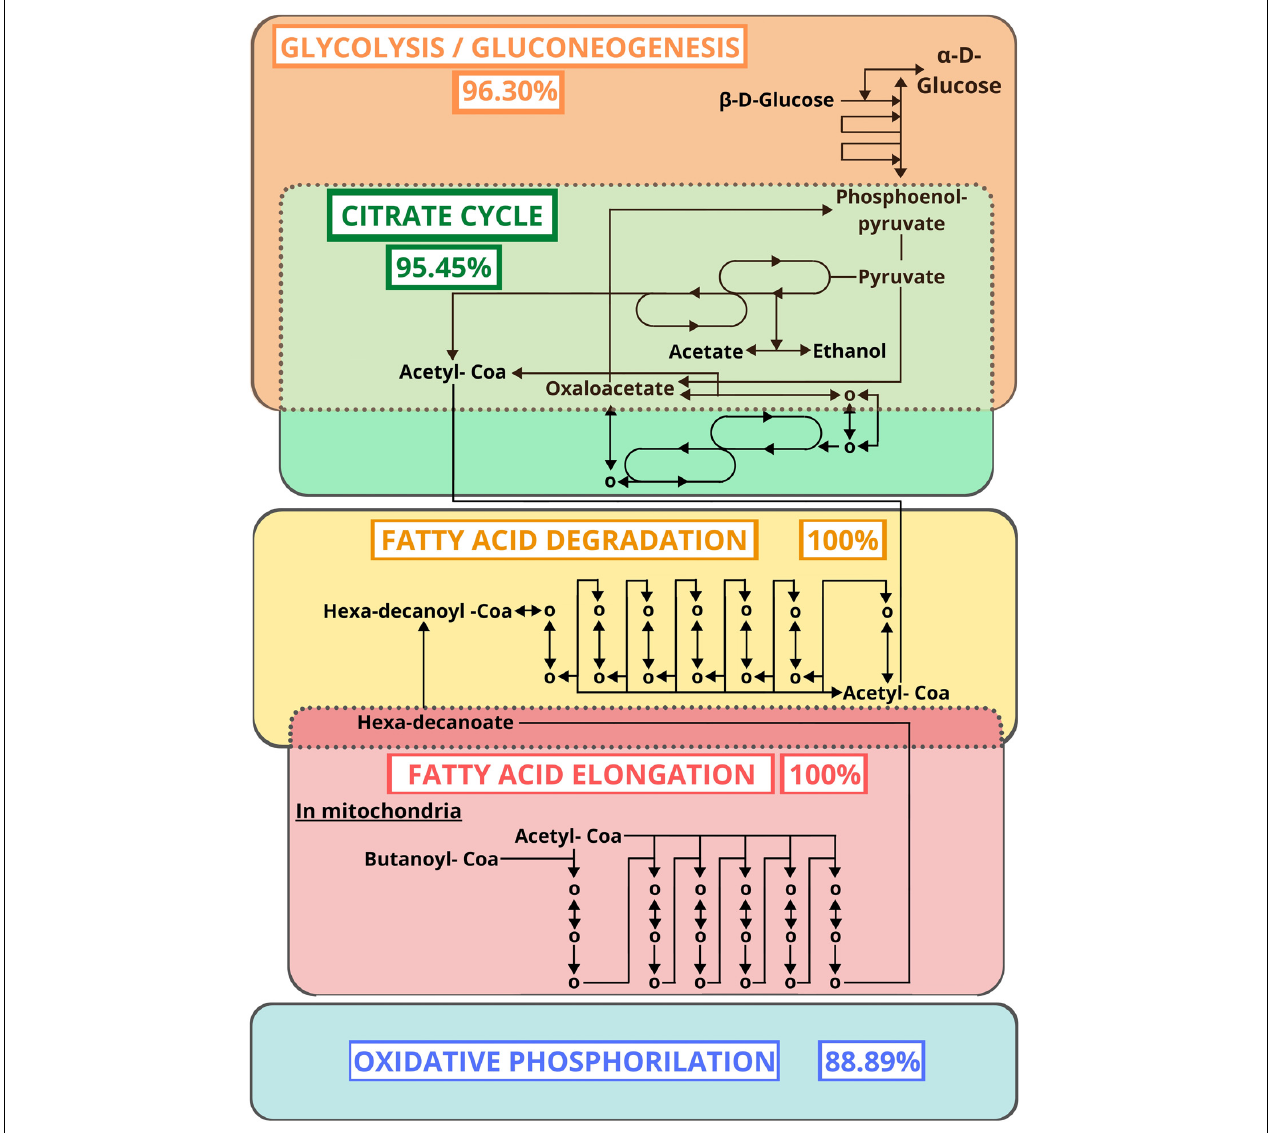
FIGURE 3 | Metabolic pathways (KEGG) with the highest proportion of mapped ECs after excluding alternative routes. The percentages represent the proportion of ECs found by similarity search.